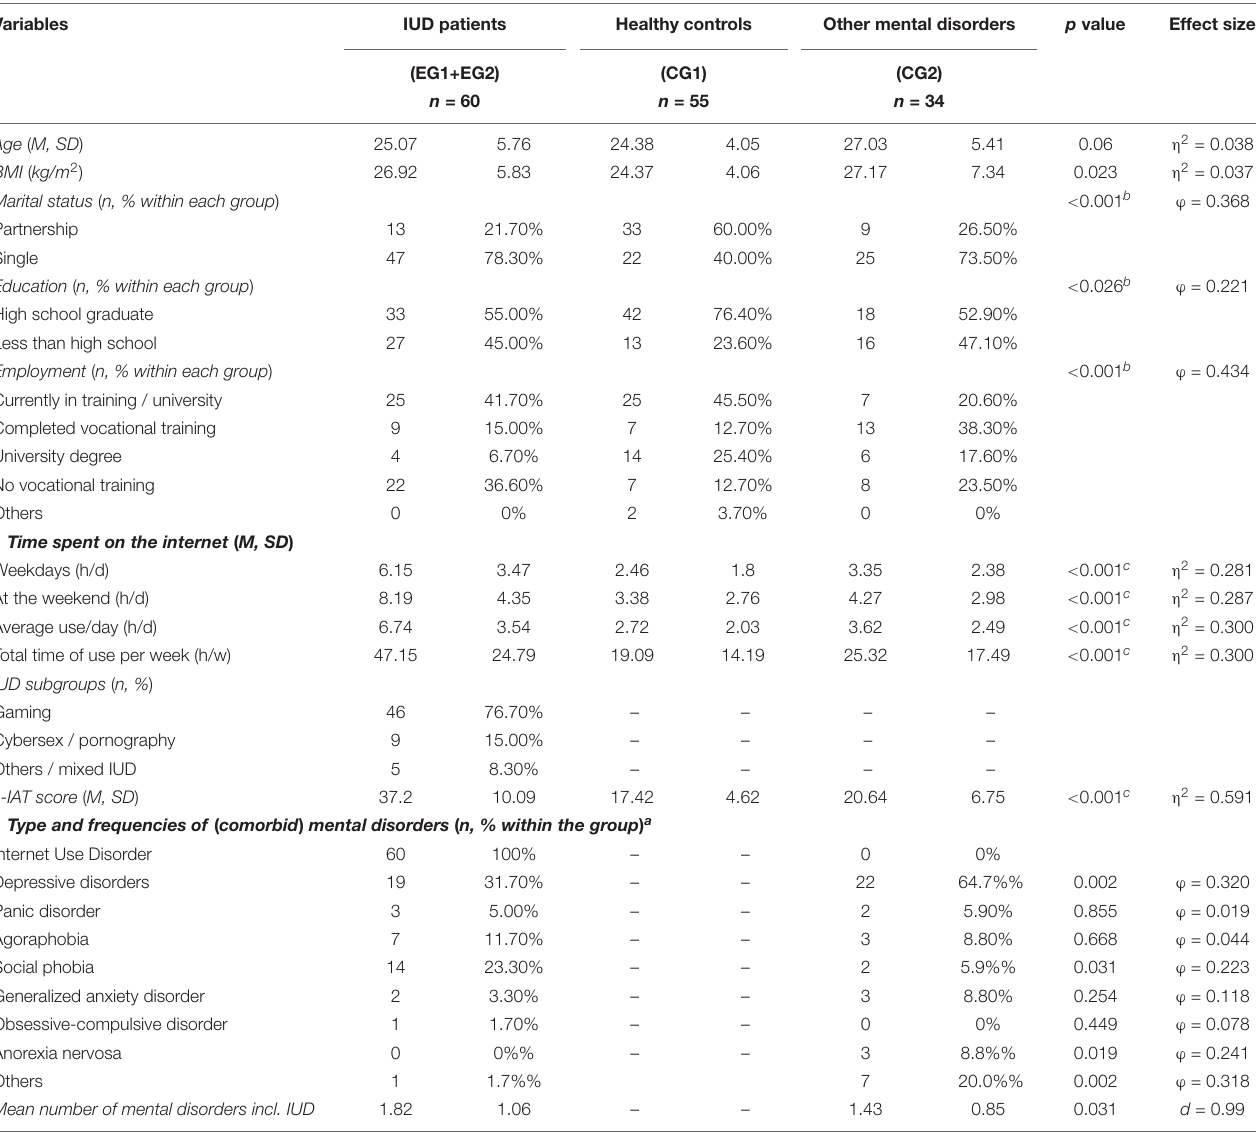
TABLE 1 | Group differences on sociodemographic characteristics and internet use disorder (IUD)